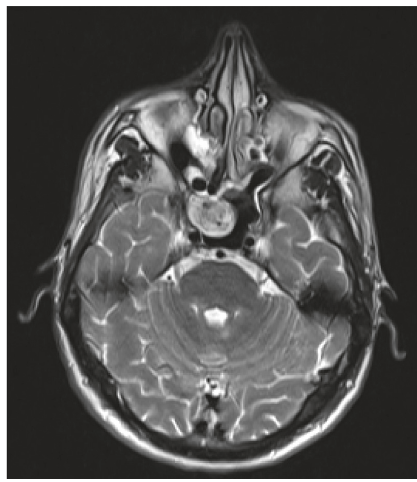
Figure 1: Magnetic resonance image (T-2) of angiofibroma localized in the sphenoid sinus.